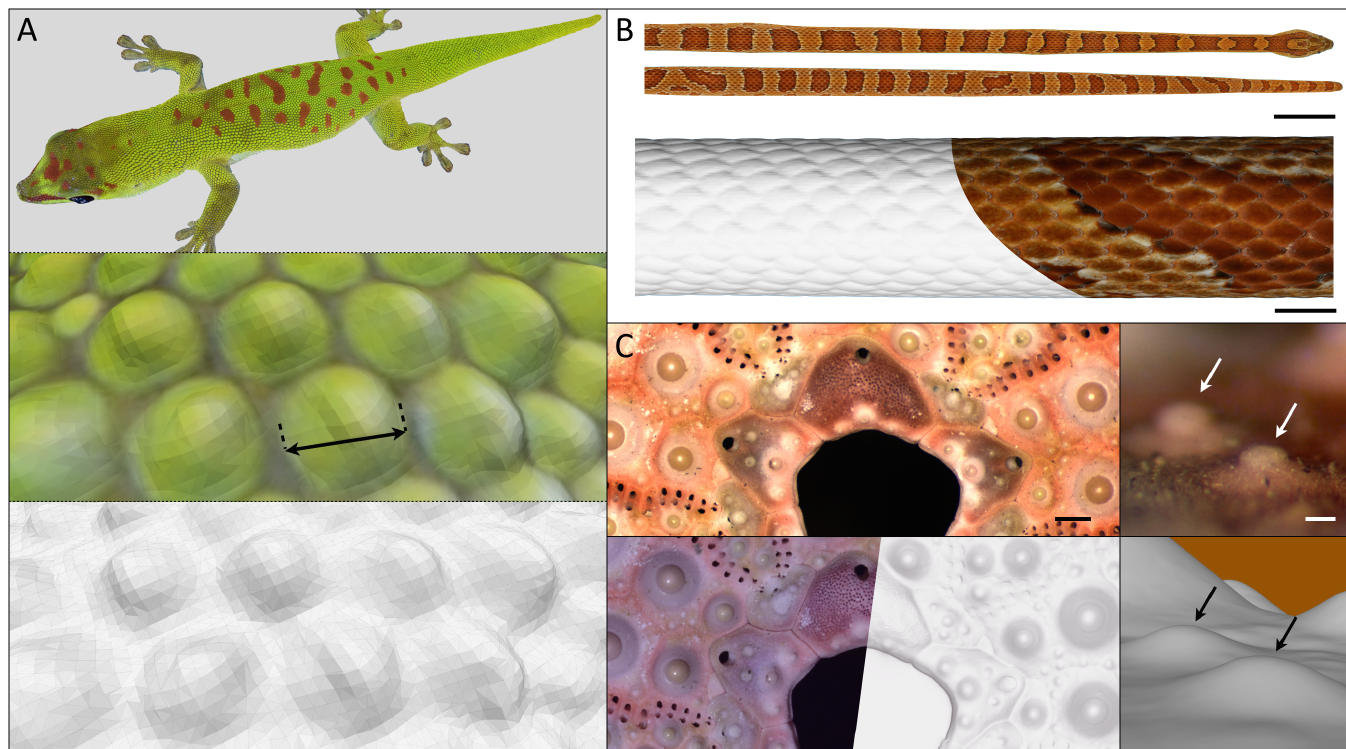
Fig 4. Animal scans performed with R 2 OBBIE. A) An adult day gecko ( Phelsuma grandis ) of 20.5cm (total length) scanned in the ‘ static support ’ configuration (74 pictures, ~5 minutes of scanning time) and reconstructed with PMVS (~6 hours of reconstruction time); upper panel, overall view; mid panel, close-up with shaded geometry and colour texture (double-headed arrow: 1mm); lower panel, same closeup with geometry only. B) Corn snake ( Pantherophis guttatus ) scanned in the ‘ hanging anaesthetised snake ’ configuration (424 pictures, ~25 minutes of scanning time) and reconstructed with PMVS (~24 hours of reconstruction time); upper panel, overall view with shaded geometry and colour texture; lower panel, close-up of the shaded geometry with and without colour texture. Scale bars: 40mm (upper panel) and 5mm (lower panel). C) Sea urchin ’ s ( Echinometra mathaei ) skeleton scanned in the ‘ static support ’ configuration (30 pictures, ~20 seconds of scanning time) and reconstructed with PS (~20 minutes of reconstruction time); upper-left, photography under a stereoscopic microscope (scale bar: 1mm) without white-balance correction; lower left, reconstructed geometry with and without colour texture (with calibrate white-balance, i . e ., the colour texture is realistic); upper-right and lower right panels, stereoscope image and reconstructed geometry of two small features (arrows) of the specimen (Scale bar: 100 μ